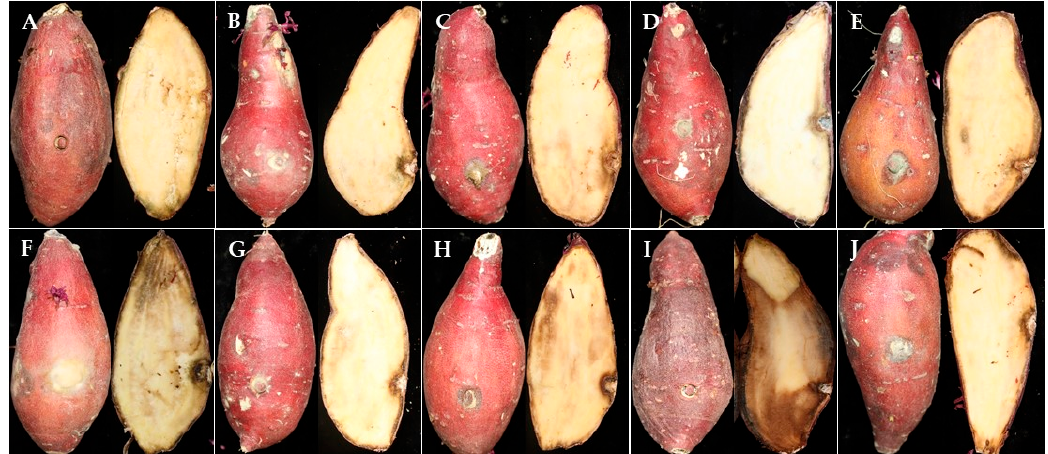
Figure 10. Pathogenicity tests of fungal isolates obtained from this study on the ‘Beniharuka’ variety. ( A ) control, ( B ) F. oxysporum CMML21–2, ( C ) A. wentii CMML21–4, ( D ) P. citrinum CMML21–5, ( E ) P. rotoruae CMML21–7, ( F ) F. ipomoeae CMML21–8, ( G ) Mu. variicolumellatus CMML21–12, ( H ) F. oxysporum CMML21–13, ( I ) M. phaseolina CMML21–15, ( J ) F. solani CMML21–17.